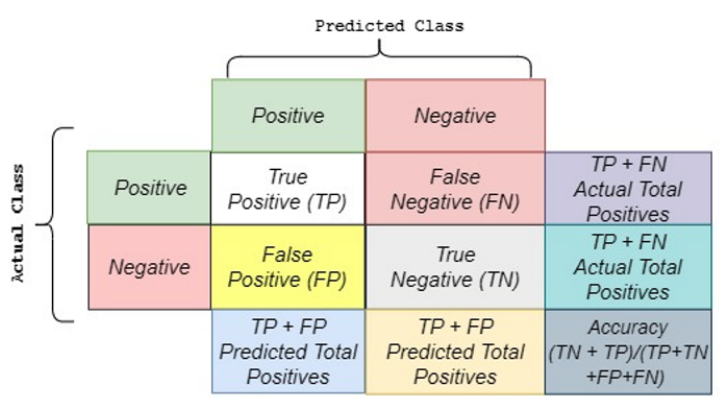
Figure 7. Confusion Matrix